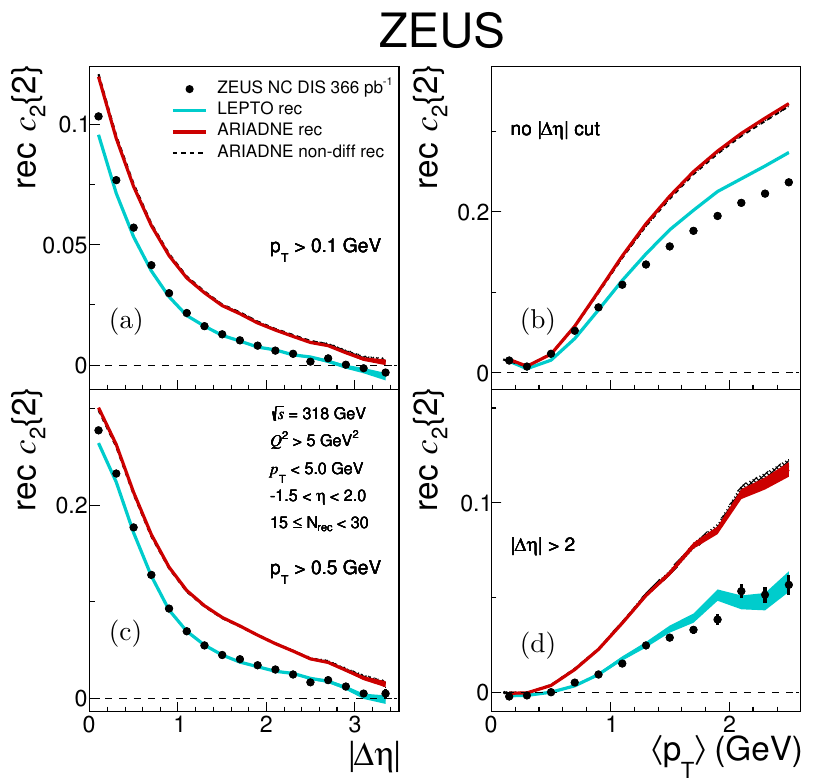
Figure 5 . Reconstructed c 2 f 2 g as a function of j (cid:1) (cid:17) j and h p T i . The other details are as in (cid:12)gure 4.